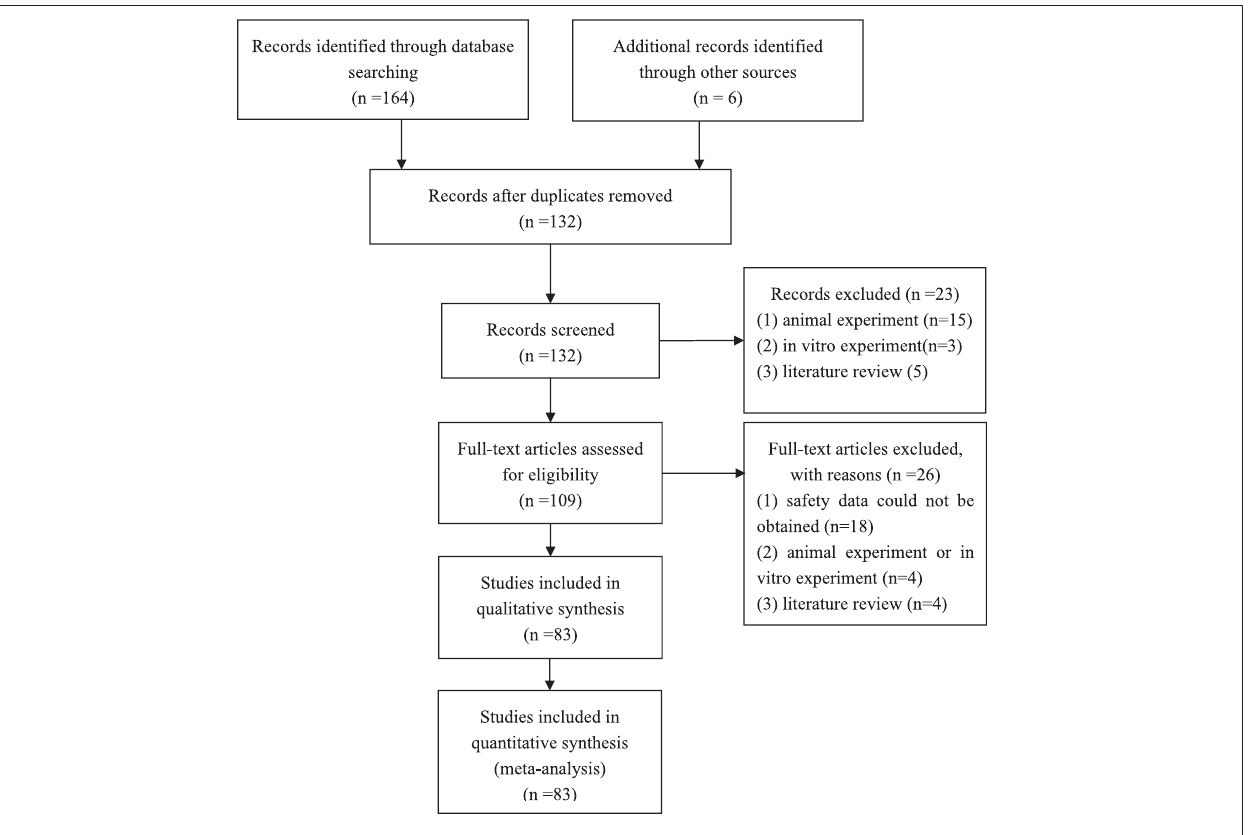
FIGURE 1 | Flowchart of literature search and study inclusion